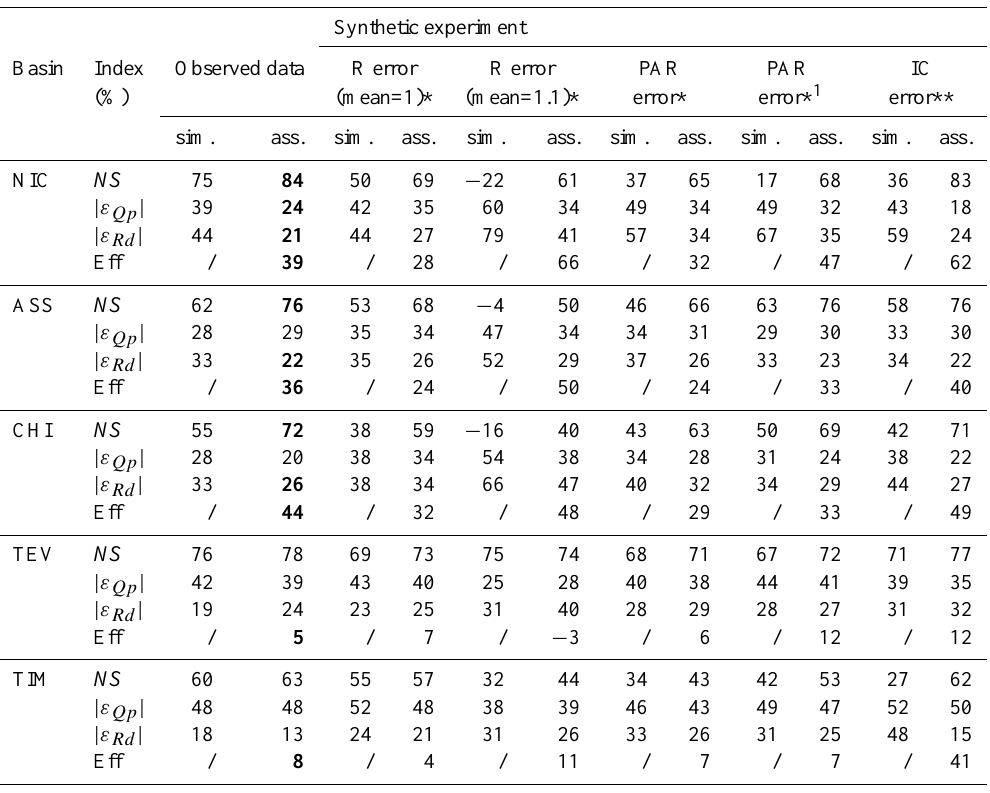
Table 2. – MISDc model performance in flood prediction with modeled, sim., and assimilated, ass., soil moisture and for different runs (R: rainfall, PAR: parameters, IC: initial conditions, NS : Nash-Sutcliffe efficiency index, | ε Qp | : absolute error on peak discharge, | ε Rd | : absolute error on runoff volume, Eff: efficiency index for the assimilation). For the rainfall error a multiplicative factor with mean equal to 1 (unbiased) and 1.1 (biased) is considered. For the analysis with the observed data, the efficiency indices or the differences in the performance indicators with and without assimilation statistically different from zero (at a significance level less than 5%) are reported in